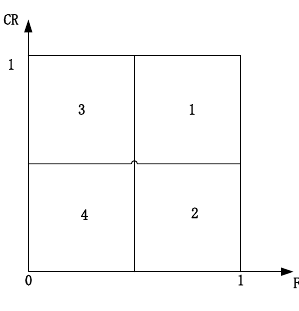
Figure 2. Individual and parameter distribution maps of three parameter strategies for f2: (a) random strategy; (b) jDE strategy; and (c) SHADE strategy.